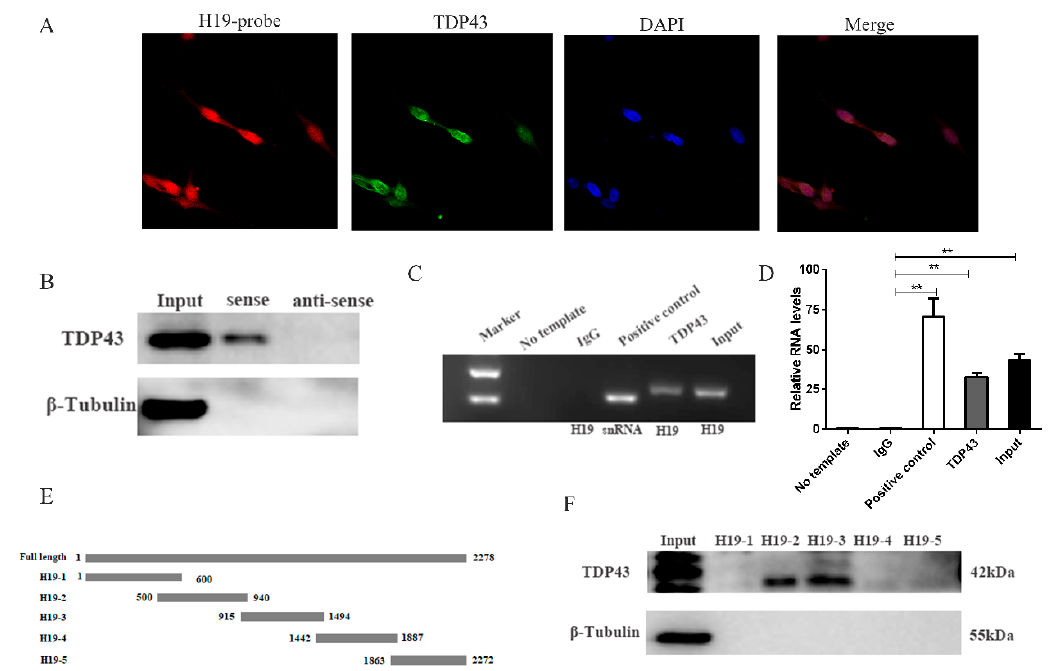
Figure 1. H19 physically interacts with TDP43. ( A ) Confocal Fluorescence in Situ Hybridization (FISH) images of co-localization of H19 and TDP43. ( B ) Biotin-labeled full-length H19 was used to pull down TDP43 protein. Western blotting analysis was performed to detect the TDP43 protein. β -Tubulin was used as negative control. ( C ) RNA Immunoprecipitation (RIP) assays were performed to validate the interaction between H19 and TDP43. SNRNP70 was used as positive control. The H19 and snRNA transcripts were assessed by PCR. ( D ) qPCR result of RIP assay. ( E ) The location of the H19 mutant fragments. ( F ) The interactions between a series of H19 mutant fragments (H19-1, H19-2, H19-3, H19-4, H19-5) were assessed by RNA pull-down assays. Mean values ± SD, n = 3. * means p < 0.05, ** means p < 0.01.